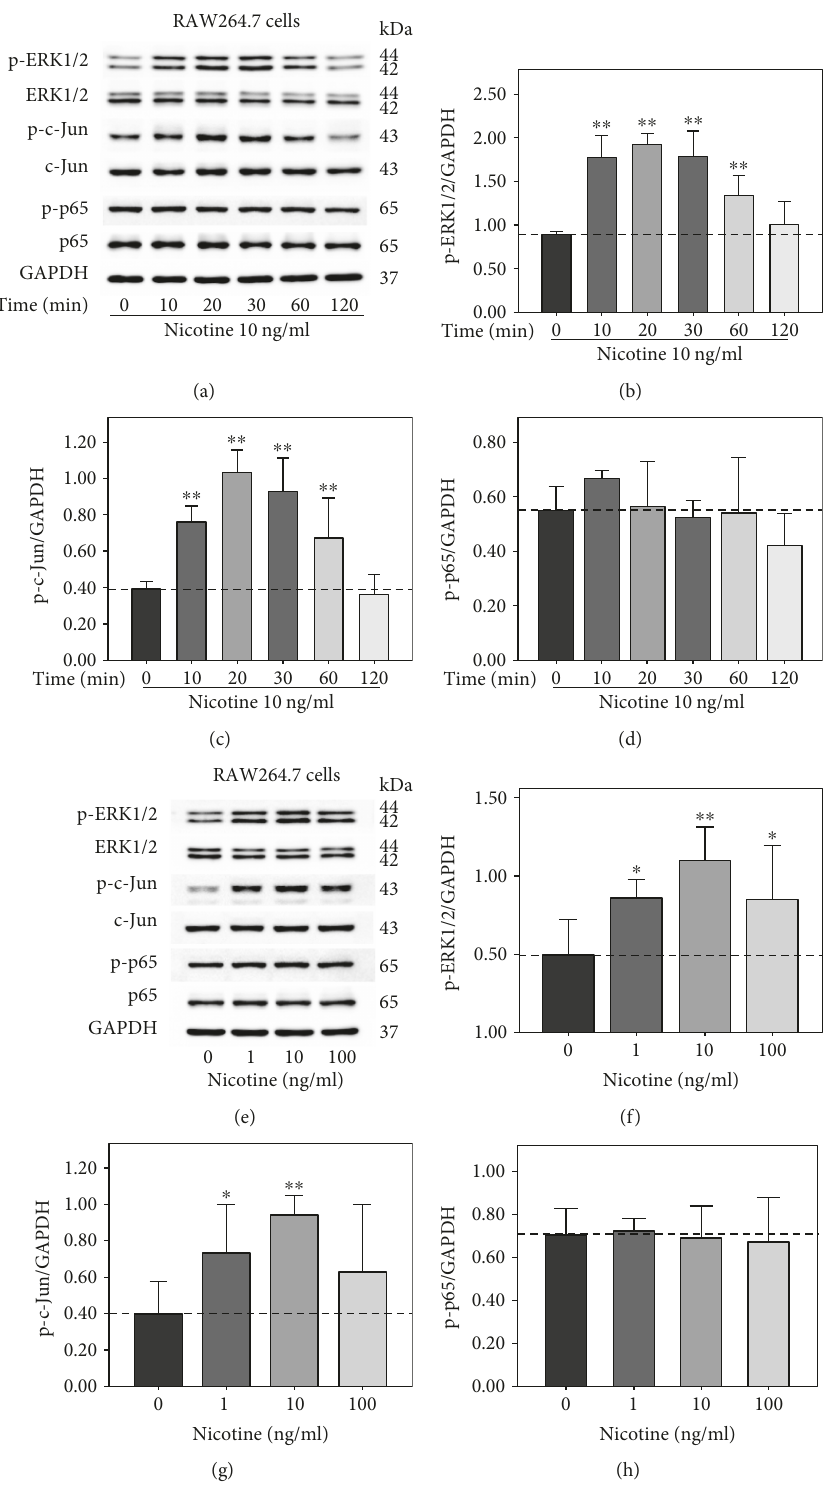
Figure 1: Nicotine stimulated the phosphorylation of extracellular signal-regulated kinase1/2 (ERK1/2) and c-Jun in RAW264.7 cells. (a) RAW264.7 cells were treated with 10 mg/ml nicotine for 0, 10, 20, 30, 60, and 120min. (e) RAW264.7 cells were exposed to nicotine for 30min at the concentrations of 0, 1, 10, and 100mg/ml. Cell lysates were collected and protein levels of p-ERK1/2, ERK1/2, p-c-Jun, c-Jun, p-p65, and p65 were measured by Western blot. The band optical density values (means ± SD) of p-ERK1/2 (b, f), p-c-Jun (c, g), and p-p65 (d, h) were evaluated using ImageJ software, with all experiments being analyzed as three di ff erent independent experiments and GAPDH used as an internal control. ∗ p < 0 05 and ∗∗ p < 0 01 versus